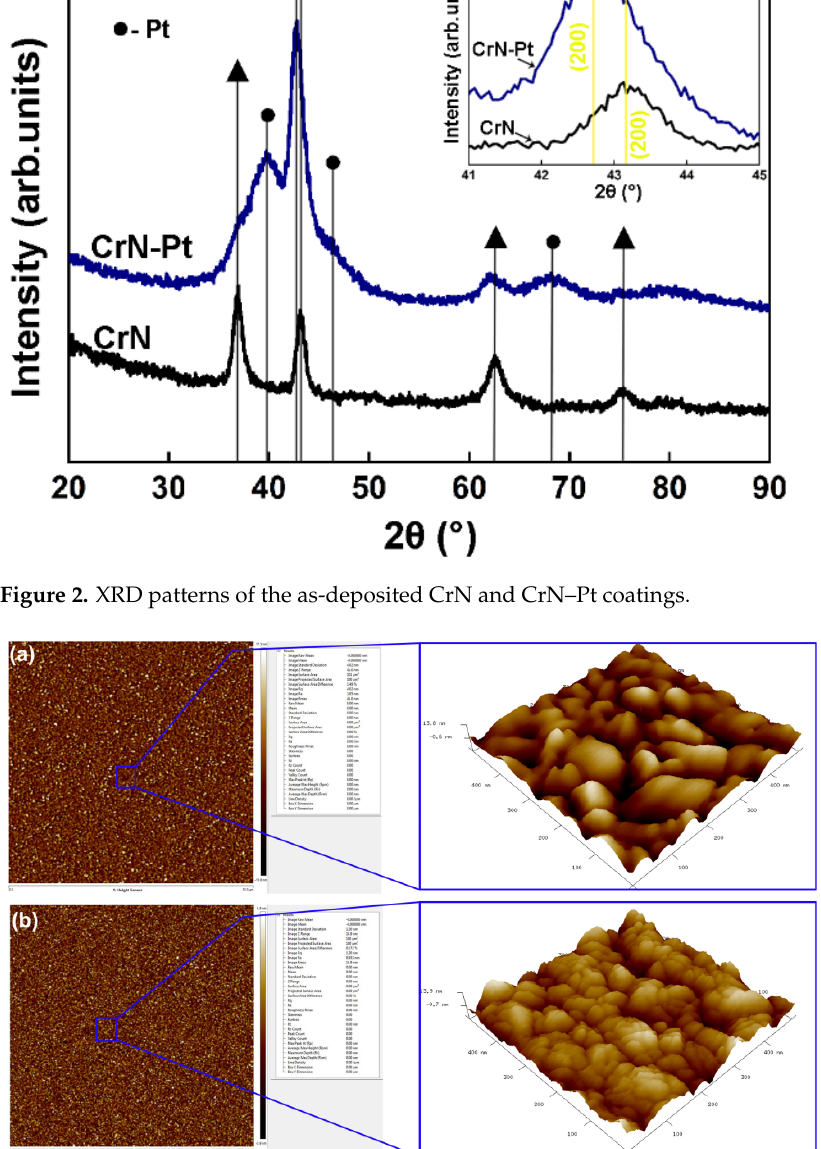
Figure 3. AFM surface images of the as-deposited coatings: ( a ) CrN, ( b ) CrN –